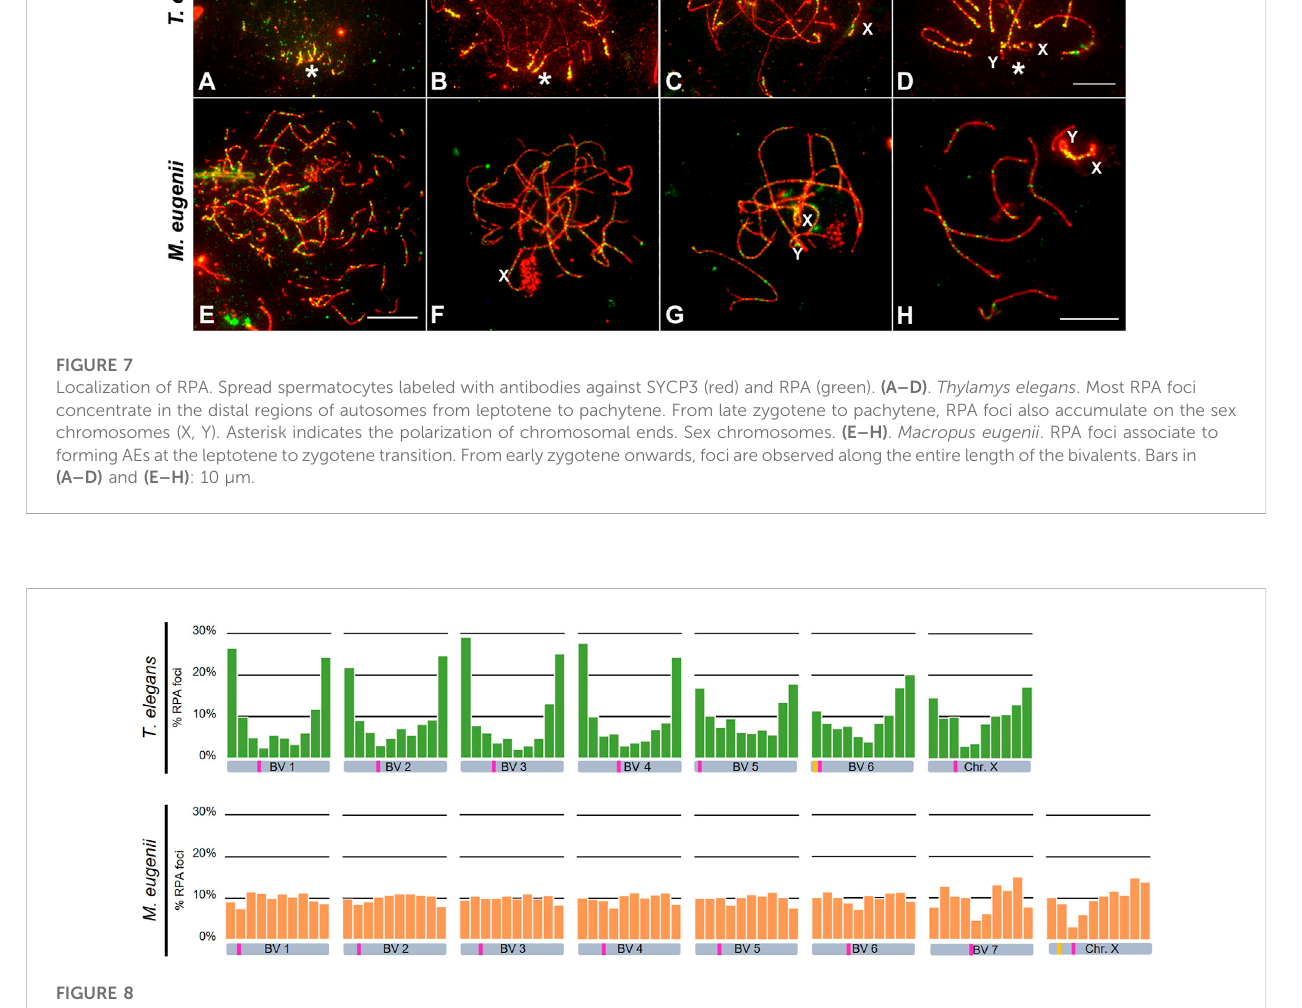
with a loose short-lived bouquet and synapsis initiating both near telomeres and interstitially.